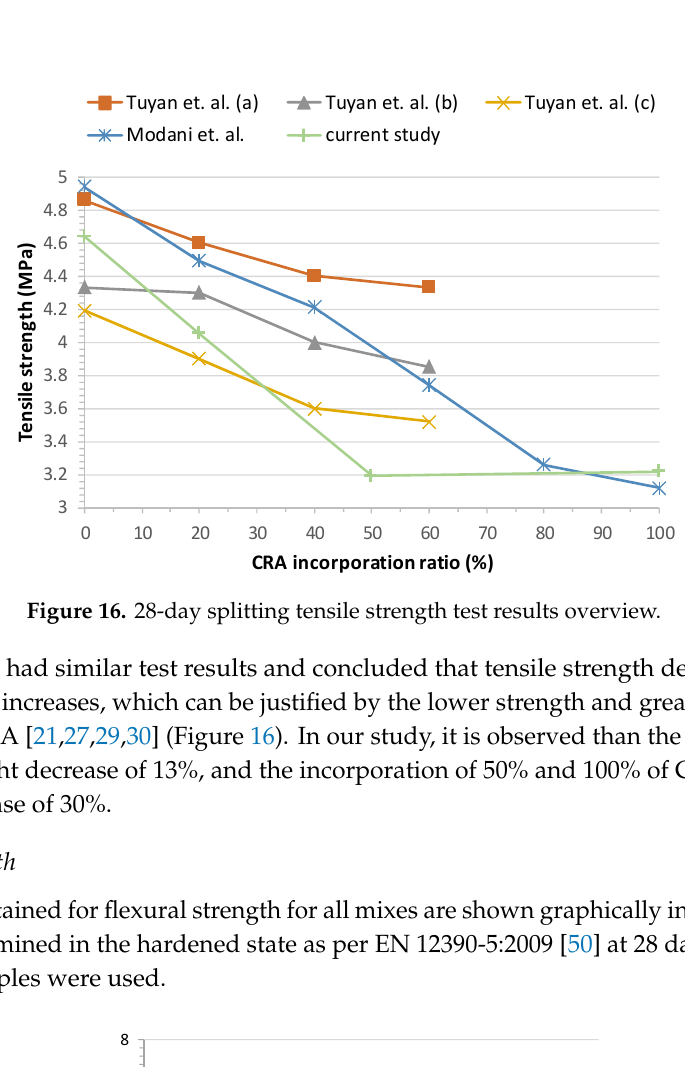
Figure 15. 28-day tensile strength test results.